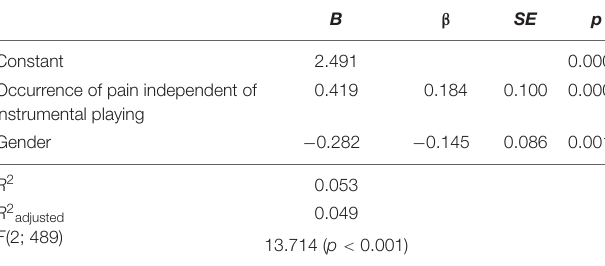
Gender reference category: male